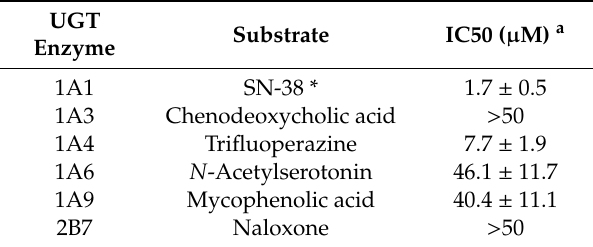
Table 6. Inhibitory e ff ects of selamariscina A against six uridine 5 (cid:48) -diphosphoglucuronosyl transferase (UGT) isoforms.